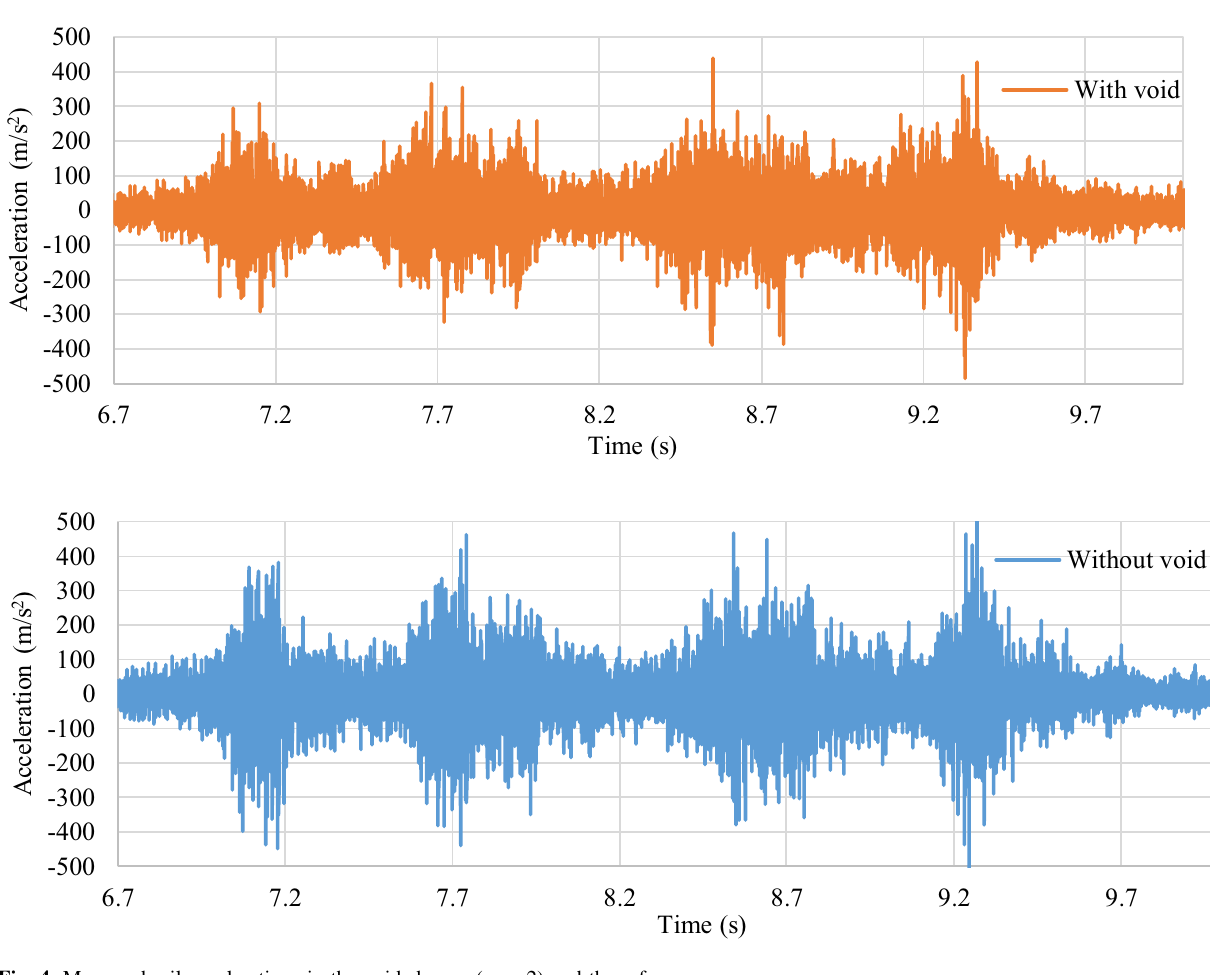
Fig. 4 Measured rail accelerations in the voided zone (case 2) and the reference